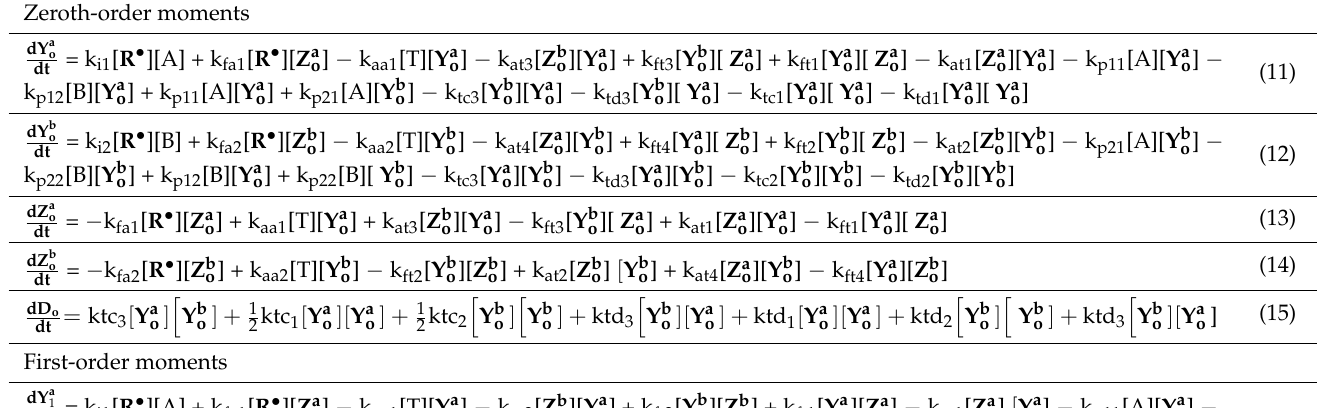
Table 4 shows the obtained moment equations. Table 4. Moment equations for the species present in the St-GMA